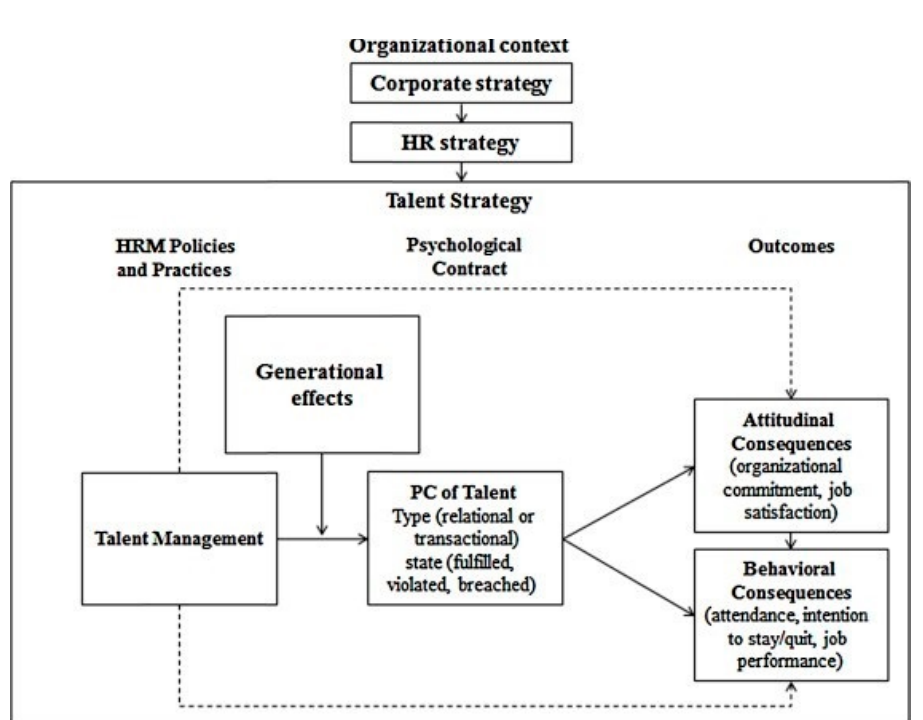
Figure 3. Relationship between corporate strategy and human resources strategy (Talent strategy). Source: Festing and Schafer